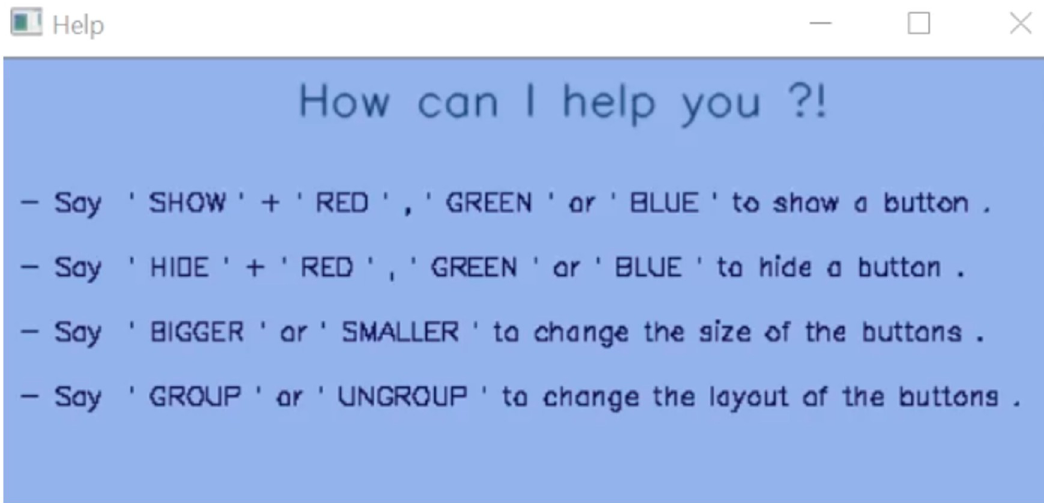
Fig 6. Automatic AUI help window.